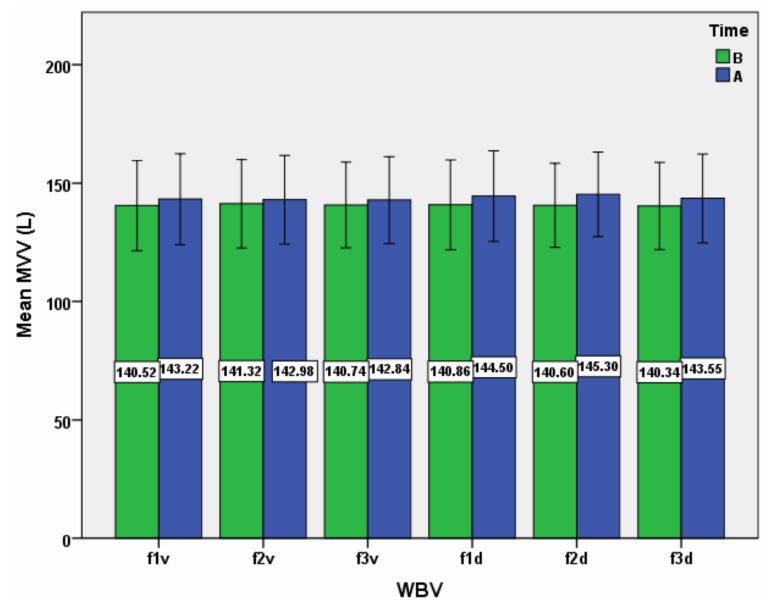
Figure 6. Impact of the WBV exposure on maximum voluntary ventilation (MVV) for the six protocols (means and standard deviations). B, before; A, after. Table 3. Results of Tests of Within-Subjects Effects for all subjects, comparing the conditions “before and after” different types of WBV